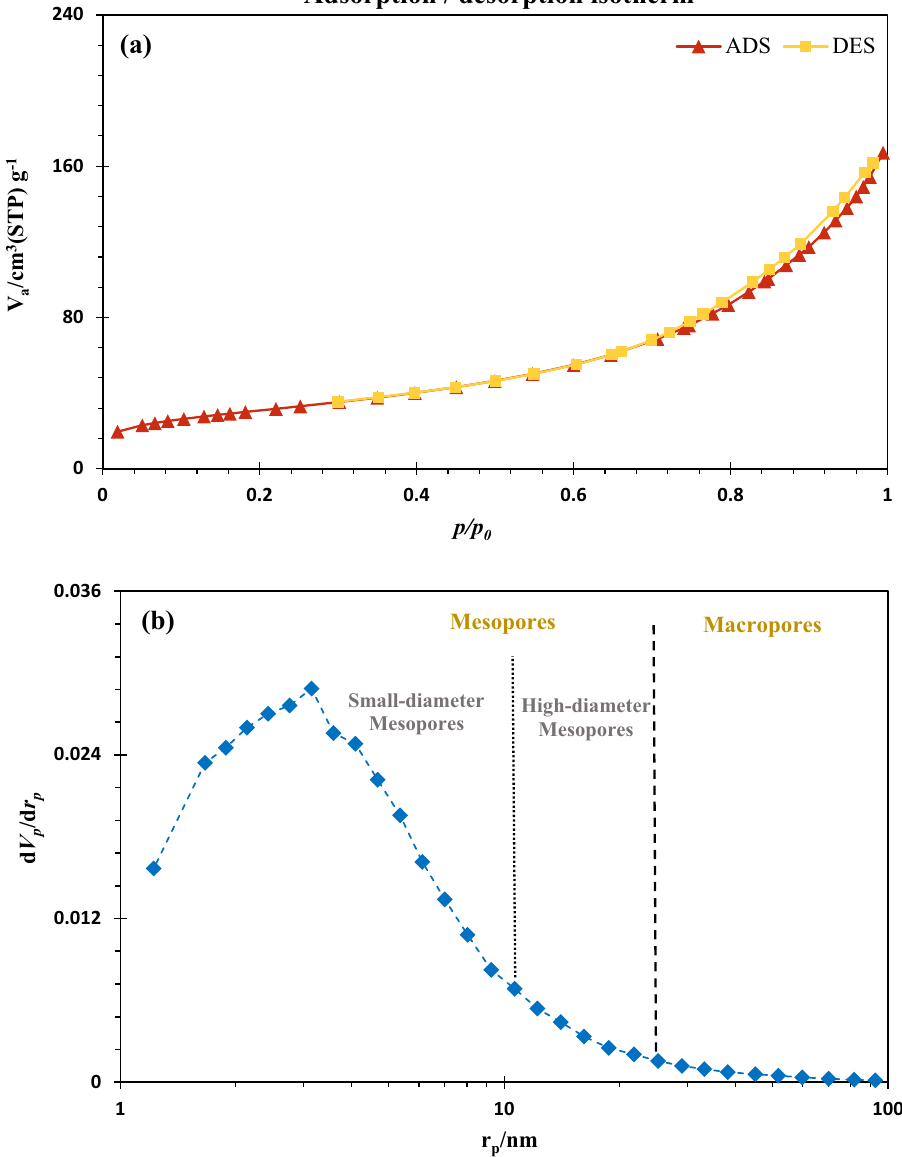
Figure 10. ( a ) N 2 adsorption/desorption isotherm, ( b ) pore size distribution curve of CuFe 2 O 4